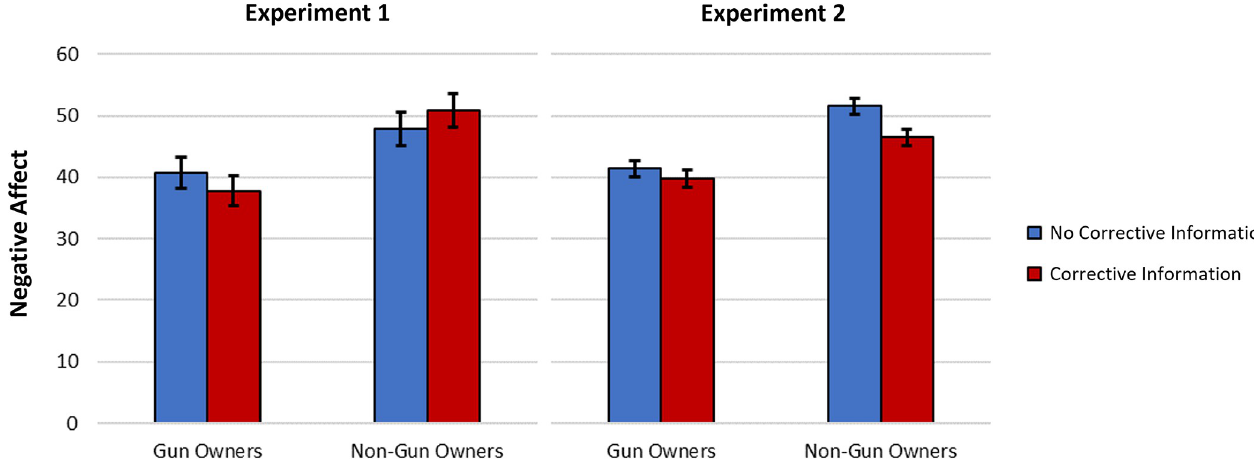
Fig 4. Negative affect towards gun and non-gun owners as a function of corrective information condition. Data from Experiments 1 ( N = 195 gun owners) and 2 ( N = 696 gun owners). Higher values indicate more negative affect. Error bars represent 95% confidence intervals.